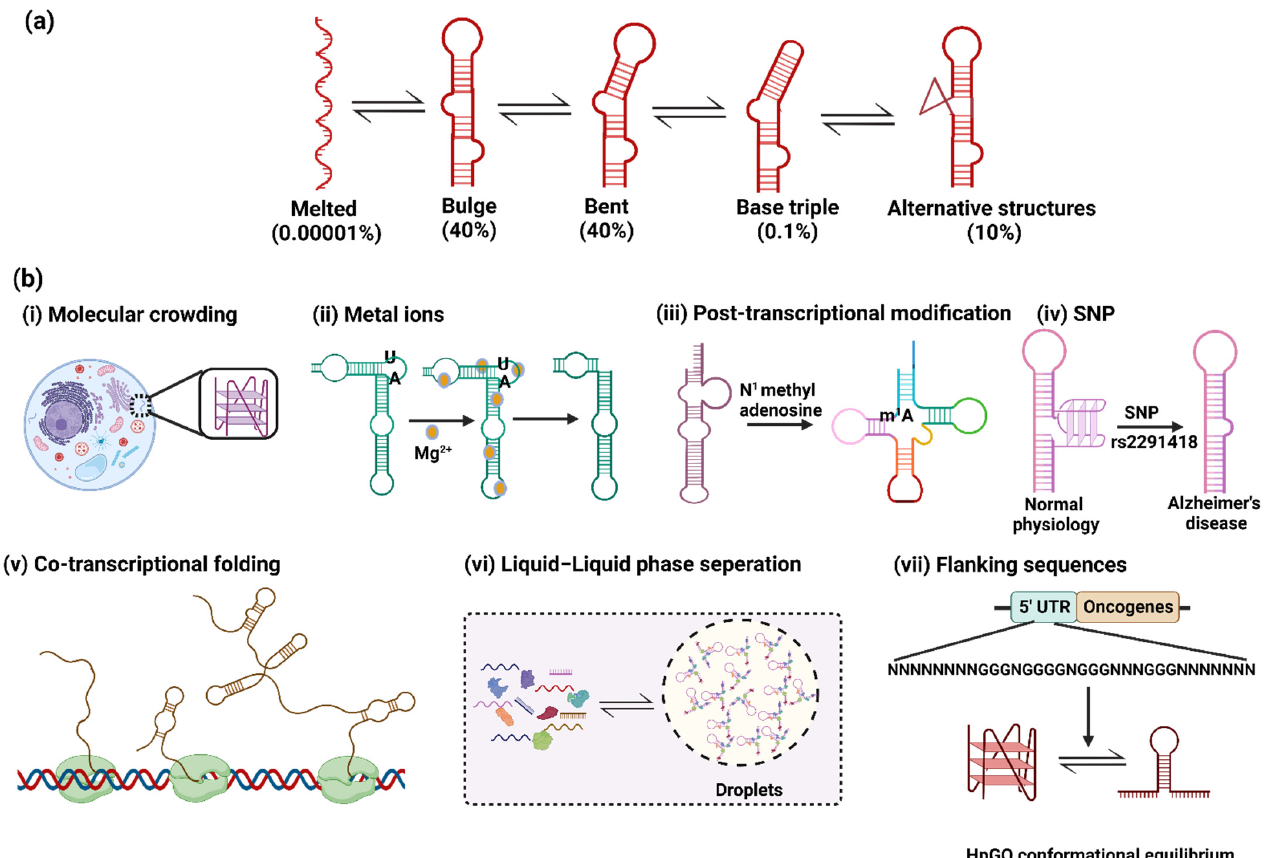
Figure 2. ( a ) HIV TAR RNA conformation ensemble consisting of diverse secondary structures with their respective populations. ( b ) Factors affecting the conformation ensemble: (i) molecular crowding in cells facilitates RNA folding in different conformations such as G-quadruplexes; (ii) metal ions like Mg 2+ are required for ribozyme functioning to disrupt AU base pairing and the exposure of catalytic domains; (iii) post-transcriptional modifications such as N 1 methyl adenosine regulate the proper folding of tRNA; (iv) the single-nucleotide polymorphism in miRNA 1229 leads to a conformational shift towards the hairpin structure, leading to Alzheimer’s disease; (v) co-transcriptional folding of RNA to form secondary structures such as hairpins; (vi) the liquid–liquid phase separation in RNA granules maintains the compartmentalization responsible for gene regulation; (vii) conformational equilibria between hairpin and G-quadruplex structures due to flanking sequences in cancer